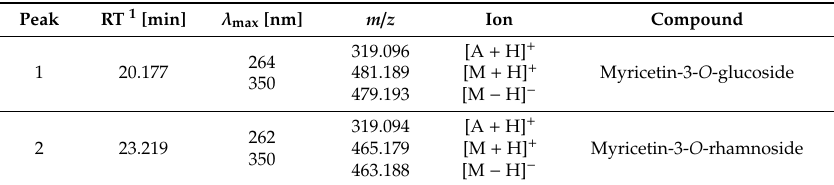
Table 1. Summary of chromatographic, UV-Vis-spectroscopic and mass spectrometric data of the main compounds 1 and 2 of the EtOH 50% extract of C. collinum.